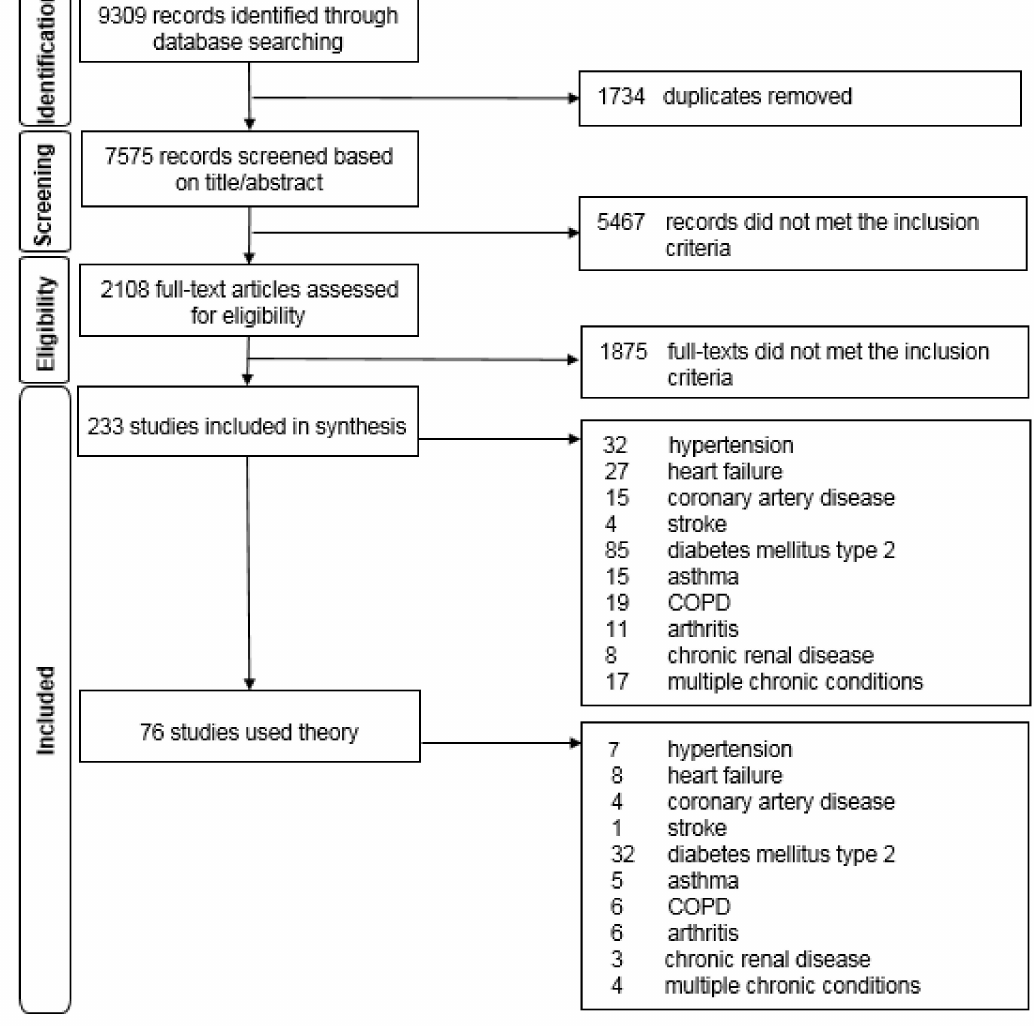
Figure 1. PRISMA flowchart of the selection of studies using theory in self-care